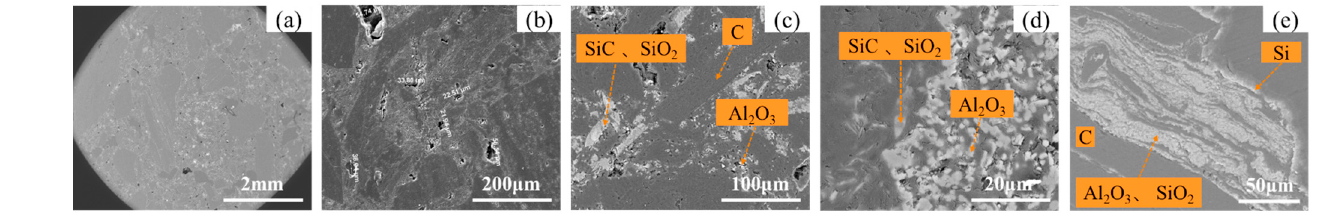
Figure 8. ( a – e ) Microscopic morphology of the original brick B under different scaleplates.